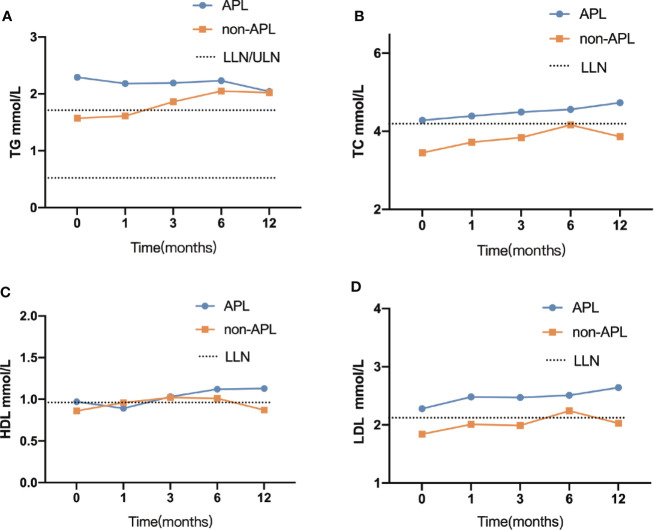
Comparison between the lipid profile at each time point. (A) TG, triglyceride (B) TC, cholesterol (C) HDL, high-density lipoprotein cholesterol (D) LDL, low-density lipoprotein cholesterol; APL, acute promyelocytic leukemia; non-APL, acute myeloid leukemia exclude of APL; ULN, upper limits of normal; LLN, lower limits of normal.